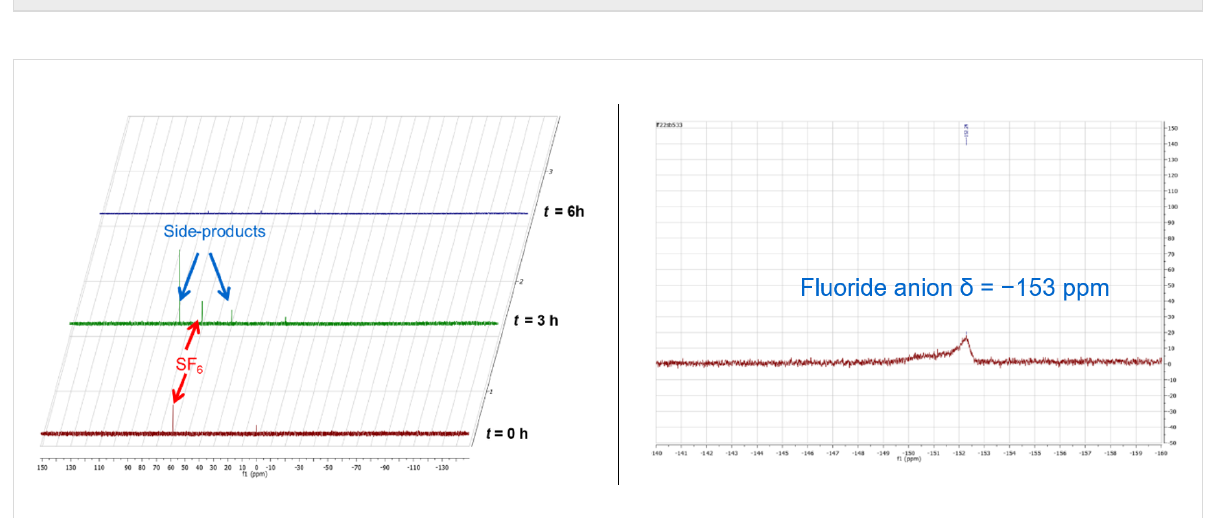
Figure 4: Electrolysis of SF 6 at − 2.3 V vs Fc + /Fc in acetonitrile freshly distilled after addition of TBAClO 4 (0.1 M) at room temperature under slight argon stream. (a) Exponential decrease of the cathodic current according to the electrolysis duration onto a smooth Pt electrode (15 cm 2 ). (b) De- crease of the cathodic current during the electrolysis duration which is detected onto an array of Pt microelectrodes (Ø = 20 µm).